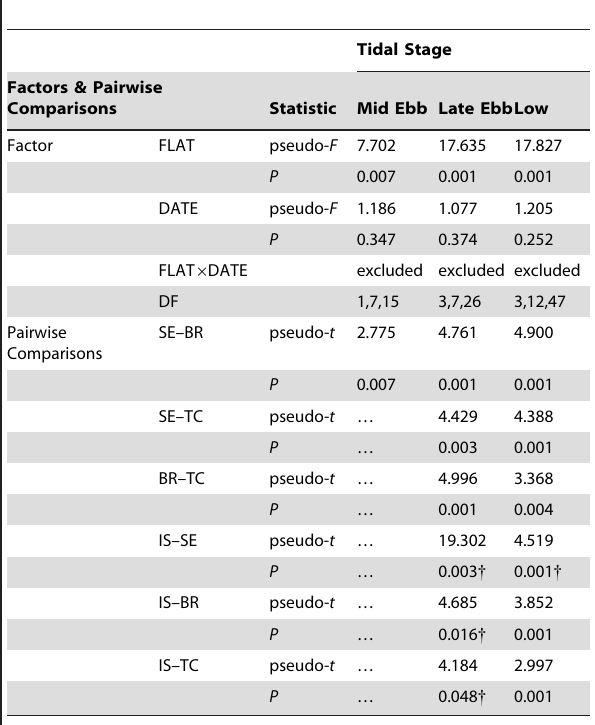
Table 1. Results of shorebird community PERMANOVA analyses testing for significance of variation among tidal